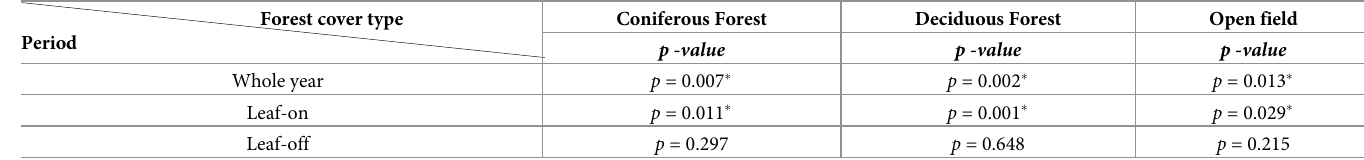
Table 4. Summary of the comparison between RMSE observed by different equipment type using a Welch’s t -test ( p-value < 0.05). Forest cover type